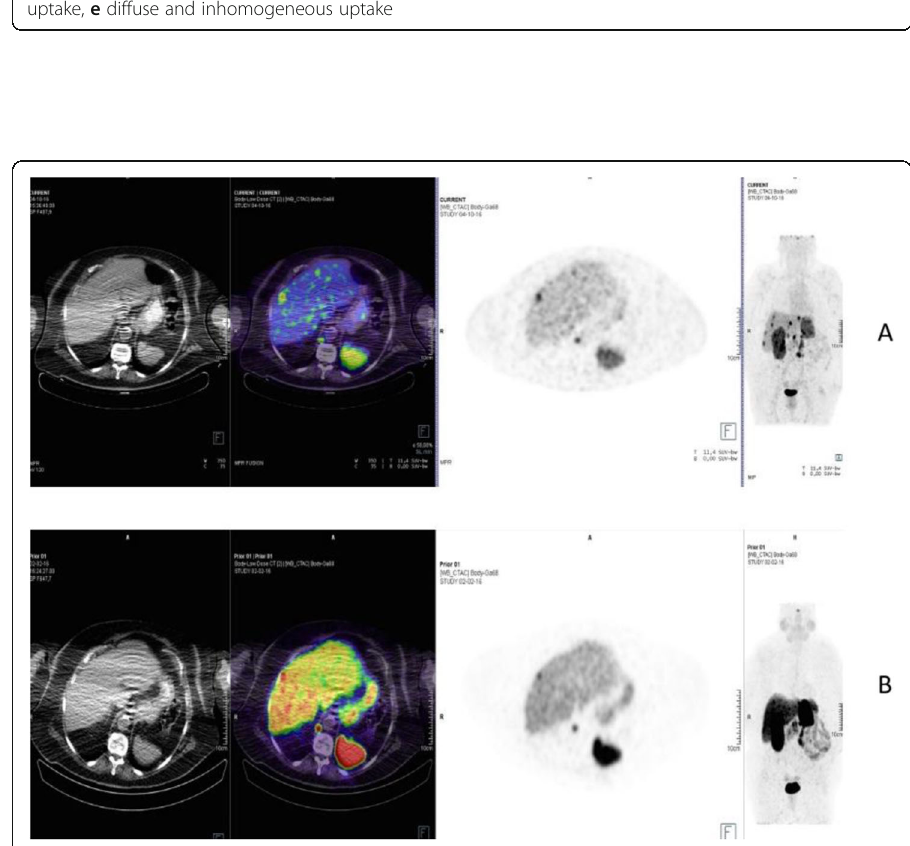
Fig. 47 68 Ga-DOTA peptide, follow-up of NET, comparison 68 Ga-DOTANOC, 68 Ga-DOTATATE. Clinical history : 68 y.o. woman with midgut NET and liver metastases treated with octreotide. PET/CT findings : 68 Ga- DOTANOC ( a ) and 68 Ga-DOTATATE ( b ) performed 8 months apart show similar uptake in the metastatic lesions, but due to the higher liver 68 Ga-DOTATATE uptake, more metastases are identified in the 68 Ga-DOTANOC